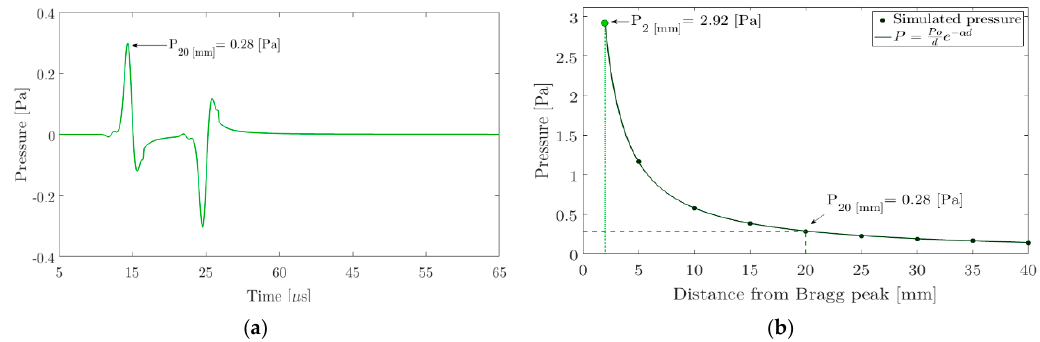
Figure 5. ( a ) Pressure received at 20 mm from the Bragg peak on the proton beam emission axis; ( b ) simulated pressure as a function of the distance.